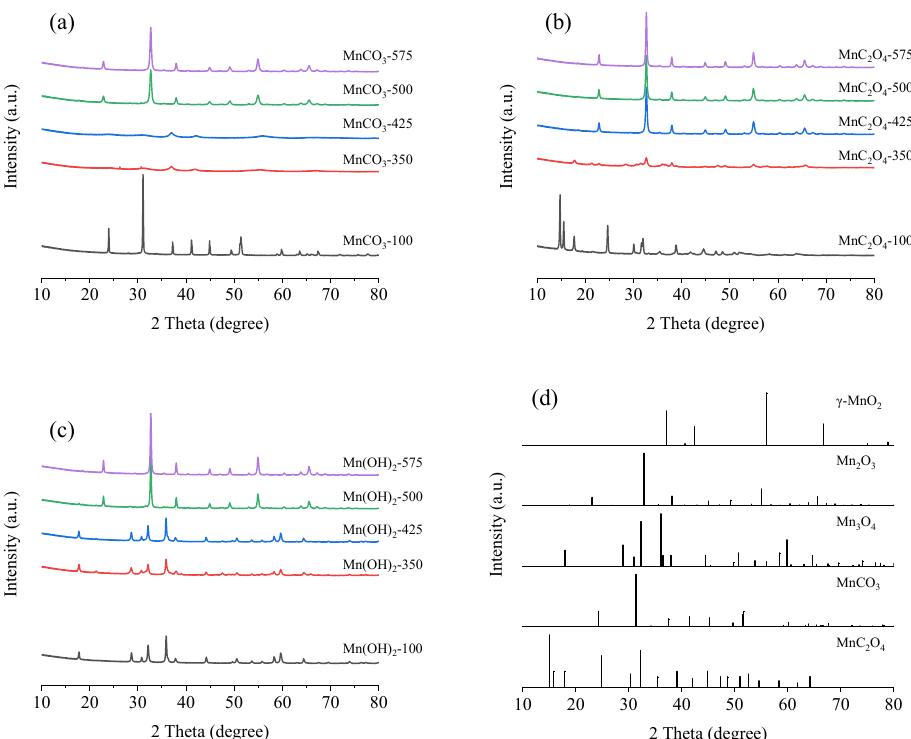
Figure 1. XRD patterns of ( a ) MnCO 3 ( b ) MnC 2 O 4 ( c ) Mn(OH) 2 calcined at di ff erent temperatures, and ( d ) standard XRD patterns of γ -MnO 2 , Mn 2 O 3 , Mn 3 O 4 and MnCO 3 .